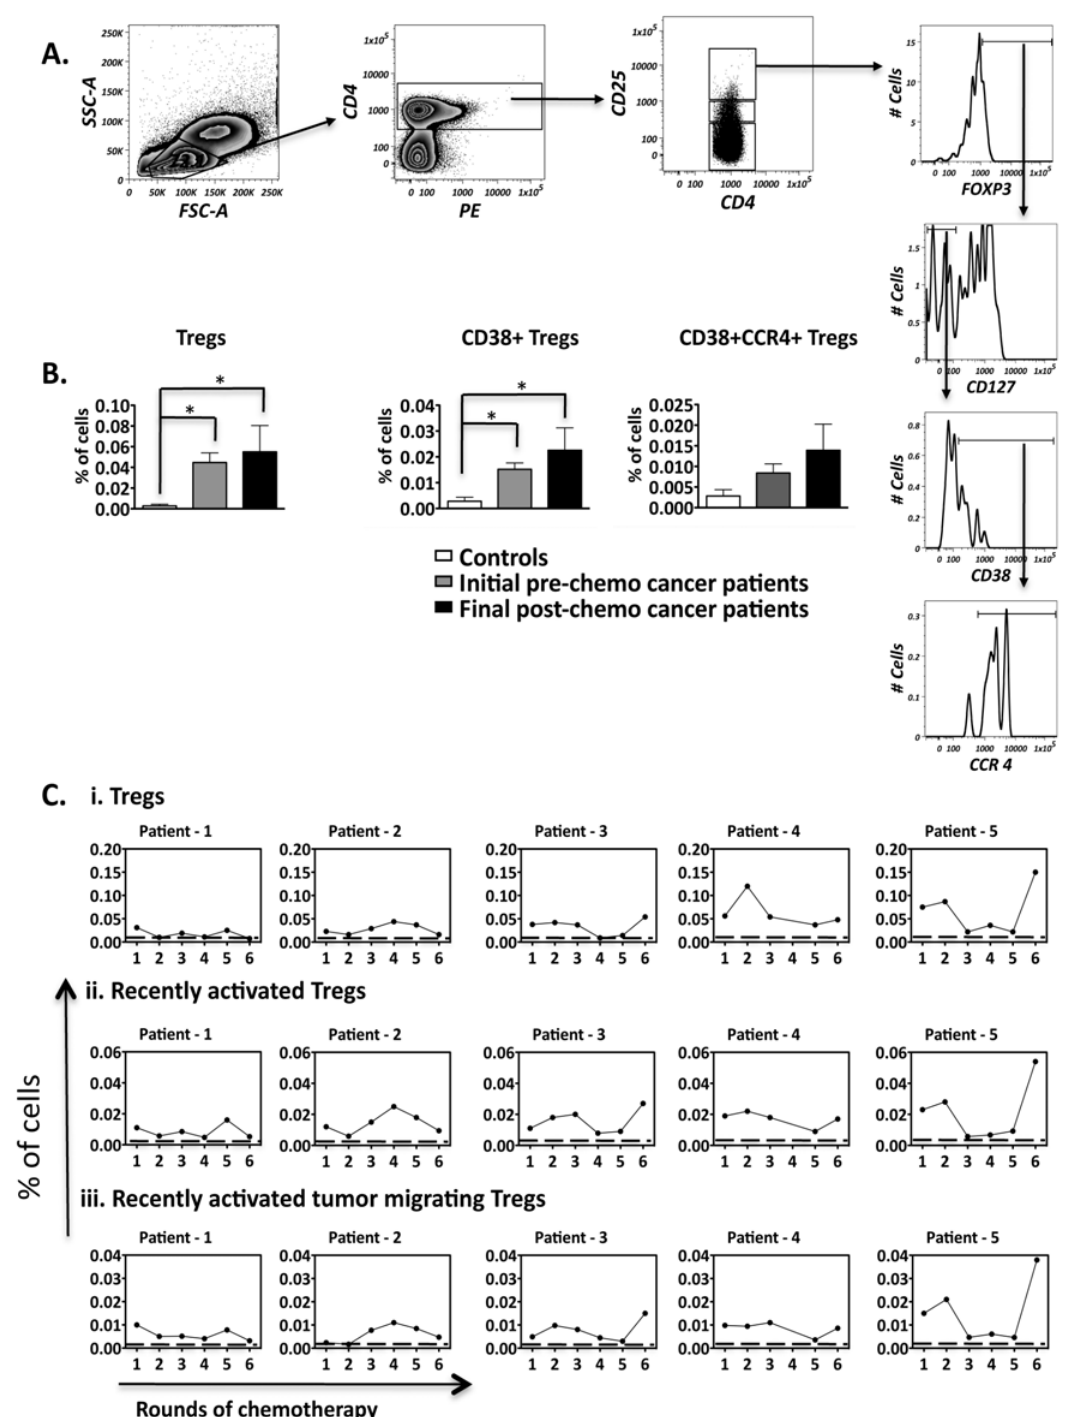
Figure 4. Frequencies of regulatory cell subsets present within the peripheral blood of ovarian cancer patients. ( A ) The gating strategy employed to identify regulatory T cells (CD4+CD25 hi FOXP3+CD127 − ) present in the PBMCs; ( B ) Comparison of regulatory T cell subset frequencies between healthy controls (n = 5) and ovarian cancer patients undergoing chemotherapy (n = 5); ( C ) Frequency fluctuations of regulatory T cell subsets of patients over the course of chemotherapy. The dotted line represents the mean frequency of the healthy controls. Comparison of regulatory T cell subset frequencies between controls and patients: * p <